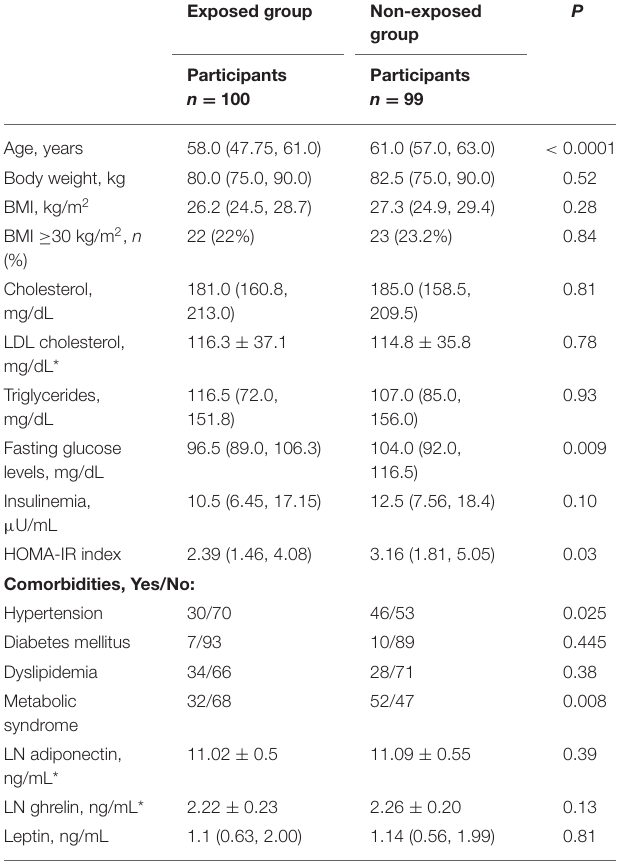
TABLE 1 | Participants’